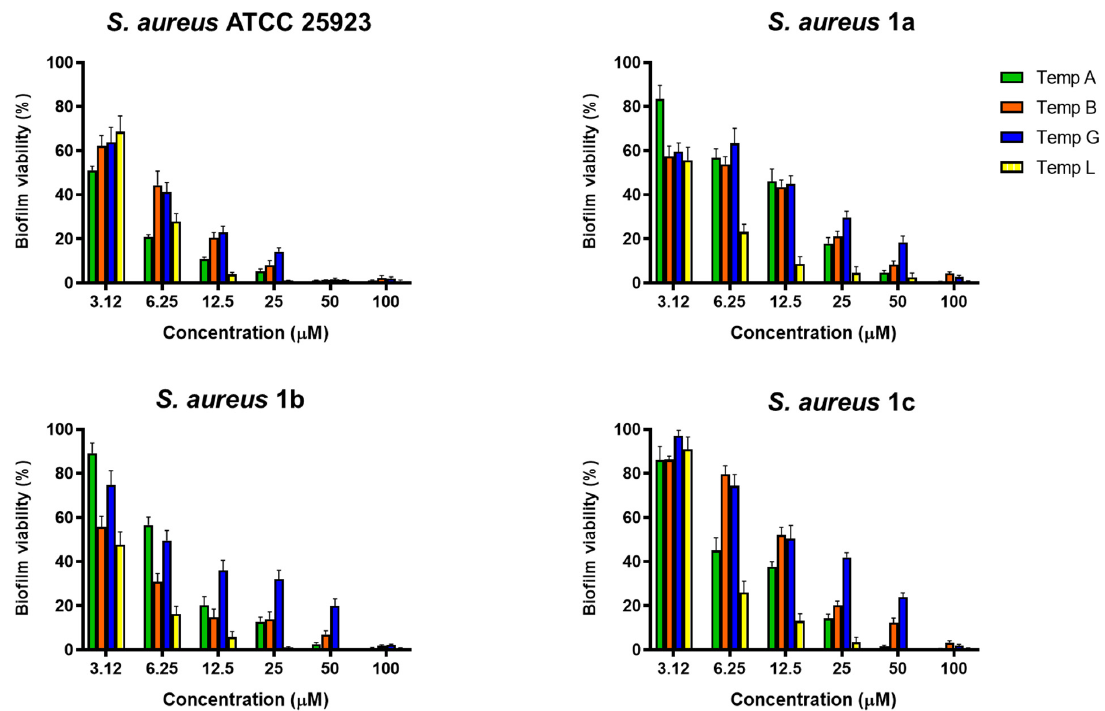
Figure 1. Anti-biofilm activity of TA, TB, TG, and TL against preformed biofilm of S. aureus ATCC 25923, S. aureus 1a, 1b, and 1c, after 2 h of treatment. Biofilm viability was determined as indicated in Materials and Methods and expressed as percentage compared to that of untreated samples (100%). Values are the mean of three independent experiments run in triplicate ± the standard error of the mean (S.E.M.). With the only exception of the values corresponding to the 3.12 µM against S. aureus 1c, all data are statistically significant ( p < 0.05) with respect to untreated samples (100% biofilm viability).